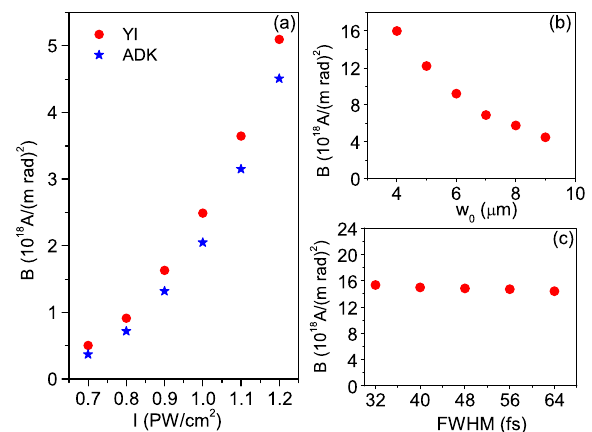
FIG. 7. The dependence of beam brightness on laser intensity, laser waist, and pulse duration are shown in (a), (b), and (c),